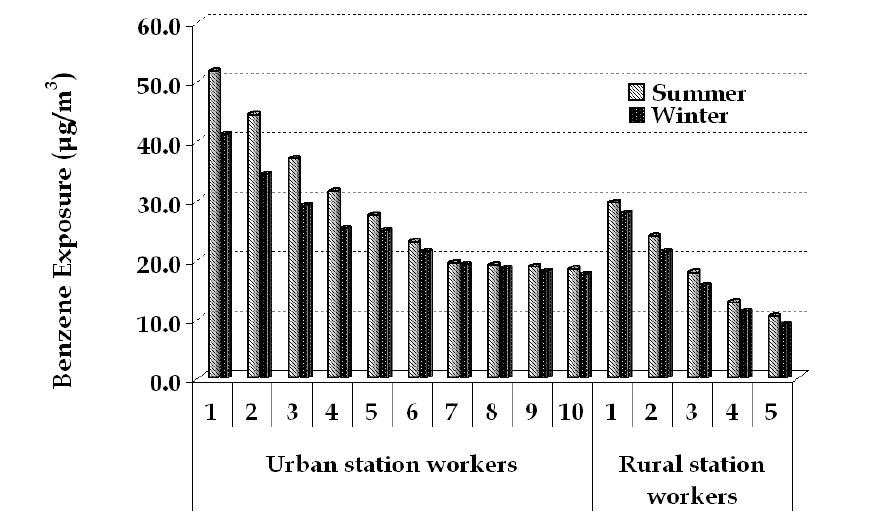
Figure 6 . Average weekly benzene exposure (in μ g/m 3 ) of the filling station employees for summer and winter